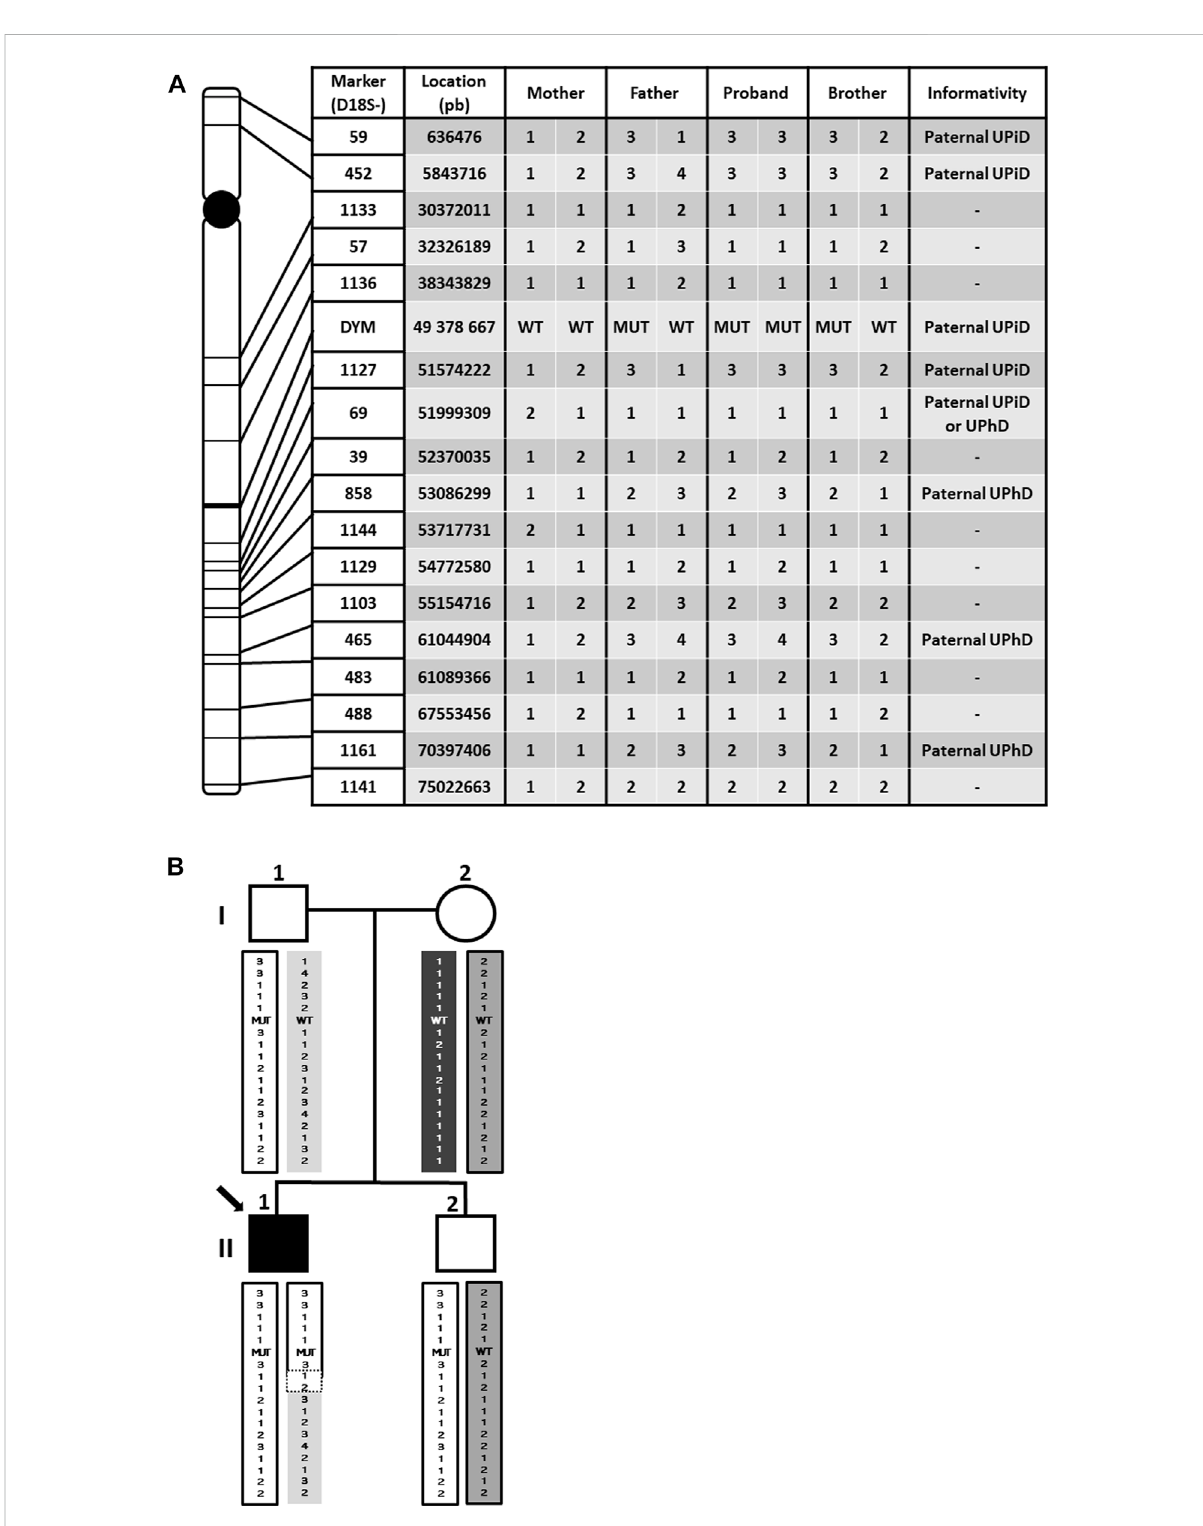
FIGURE 3 Haplotypegenotypingfor17microsatellitemarkers. (A) Locationofmarkers coveringchromosome18 andhaplotype results. UPiD:uniparental isodisomy; UPhD: uniparental heterodisomy. (B) Haplotype segregation in the family. The different haplotypes are visualized by color coding. Note that the proband contains a non-informative region delimited by dotted lines, which makes it imposible to establish the cut-off point between UPiD and UPhD. UPiD: uniparental isodisomy; UPhD: uniparental heterodisomy; WT: wildtype genotype; MUT: mutant